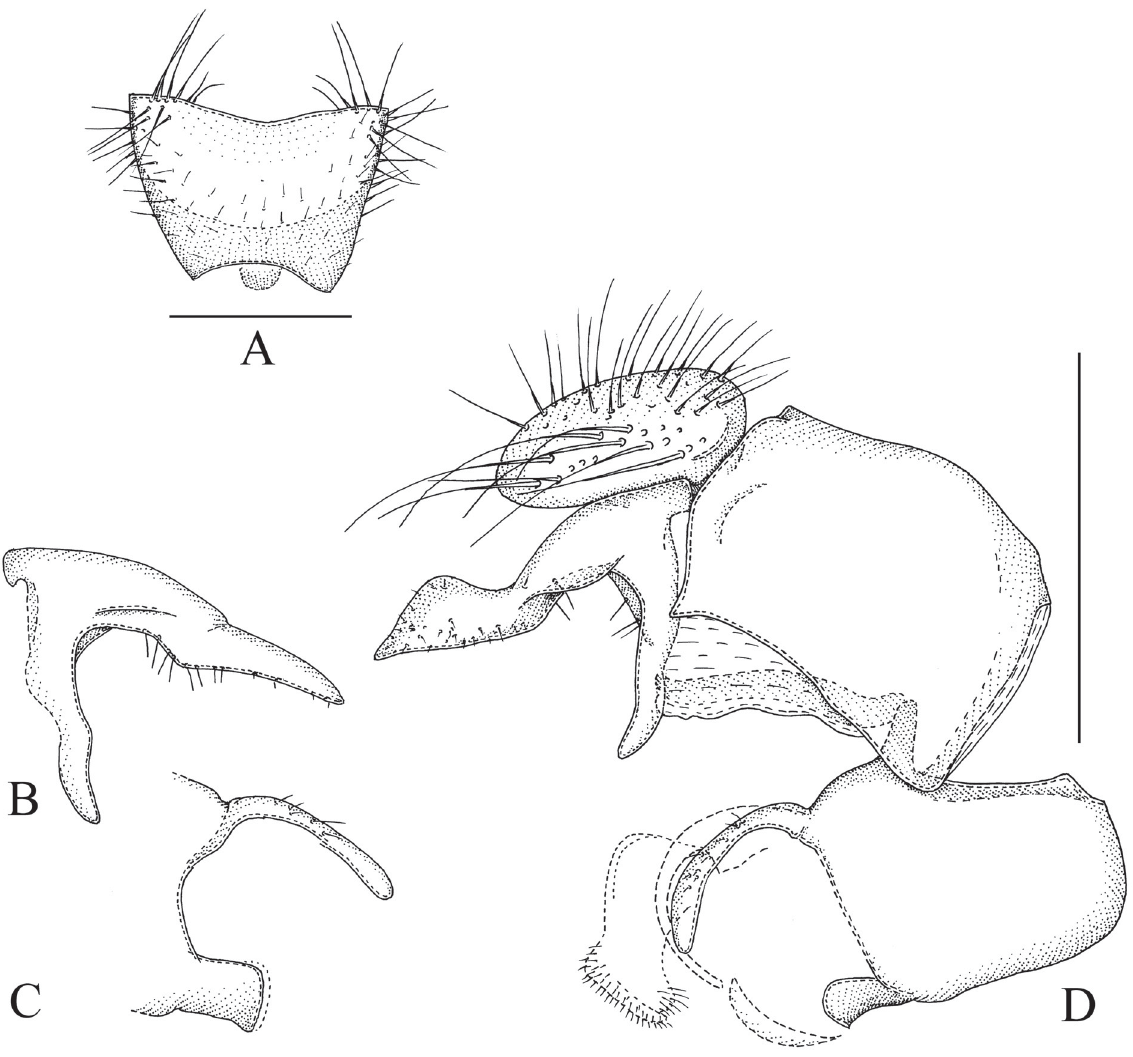
Fig. 46. Sphegina (Asiosphegina) incretonigra sp. nov., holotype, ♂ . A . Sternum IV, ventral view. B . Left surstylus, lateral view. C . Superior lobe with associated pa rts, left side, lateral view. D . Genitalia, right side lateral view. Scale bars = 0.5